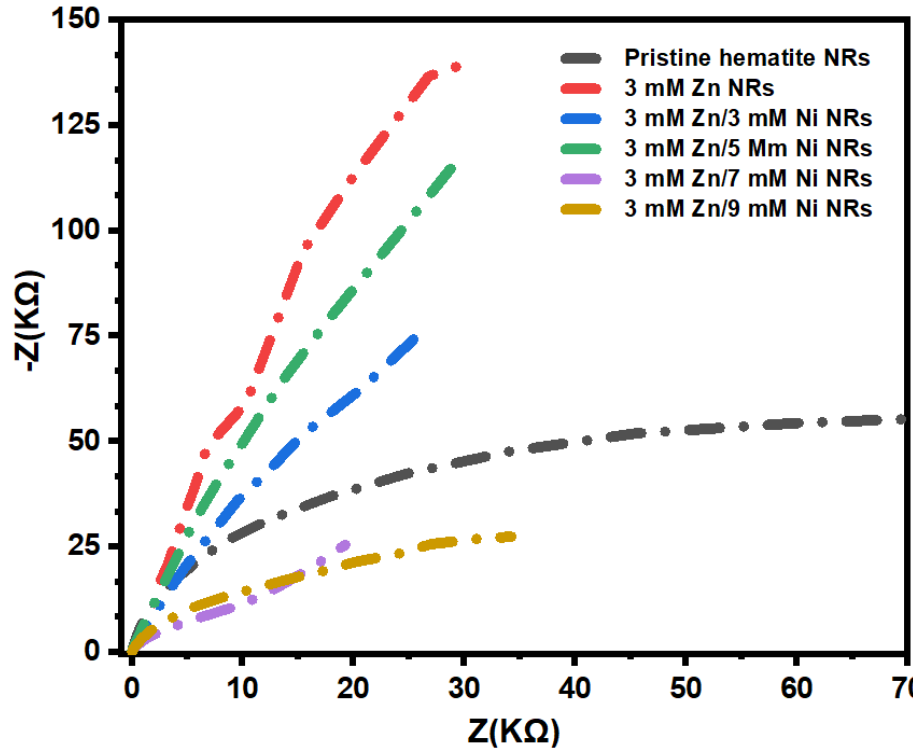
Figure 11. Electrochemical impedance Nyquist plots of pristine, Zn-doped, and Zn/Ni-doped hematite NR photoanodes.